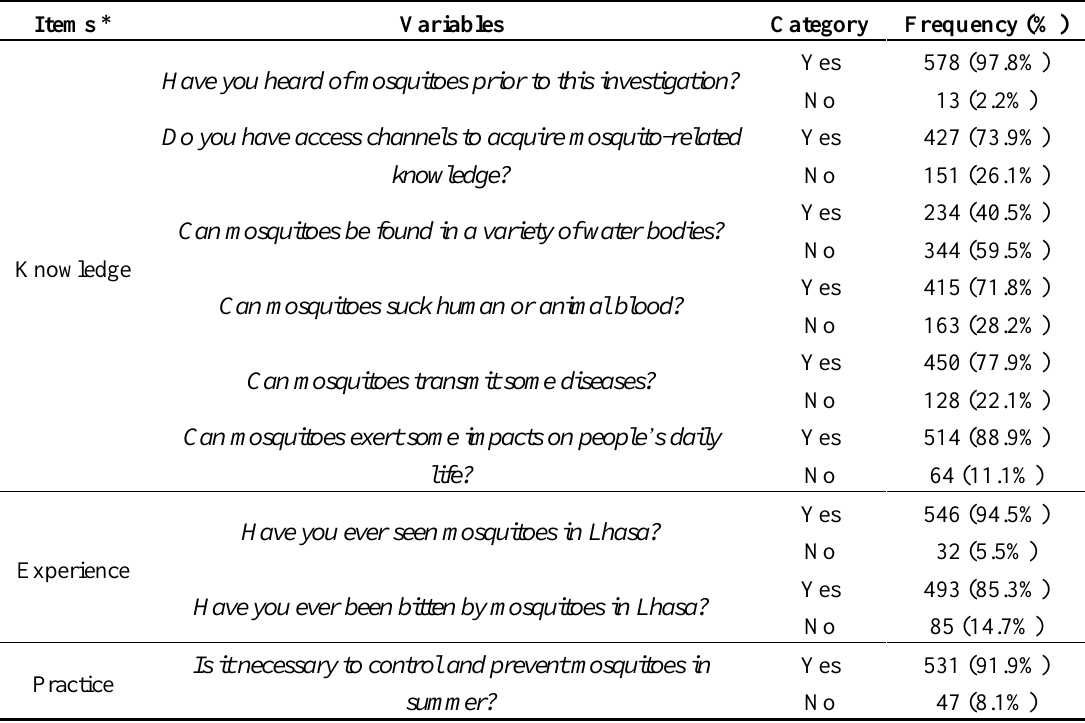
Table 2. Responses to mosquito knowledge, experience and practice